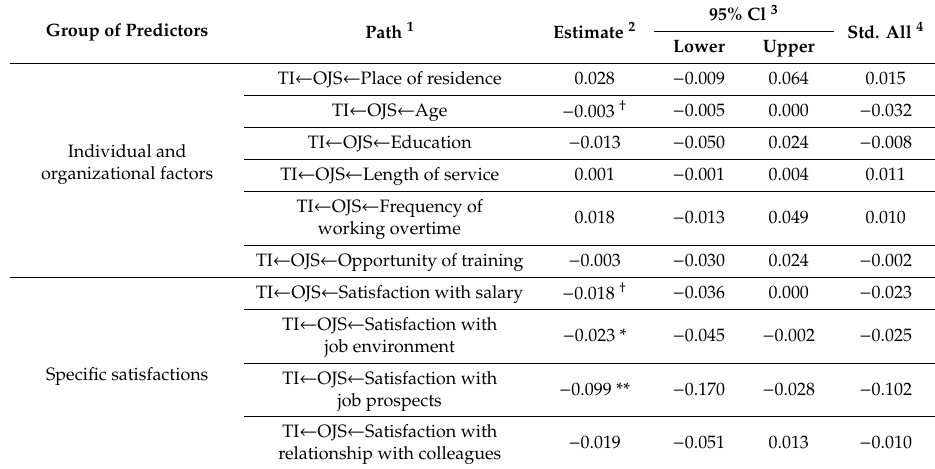
The indirect e ff ects shown by the SEM modeling (the a ff ective commitment was not